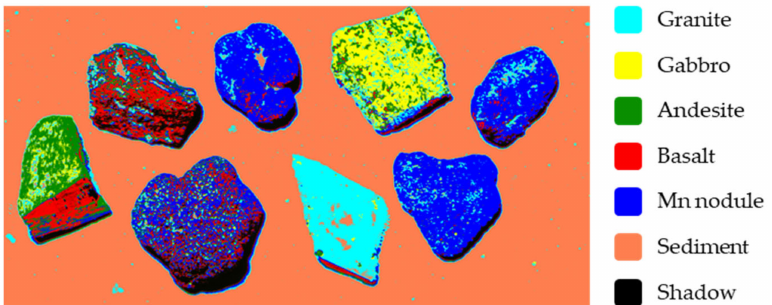
Figure 13. The SVM classification image of several mineral samples and sediment.